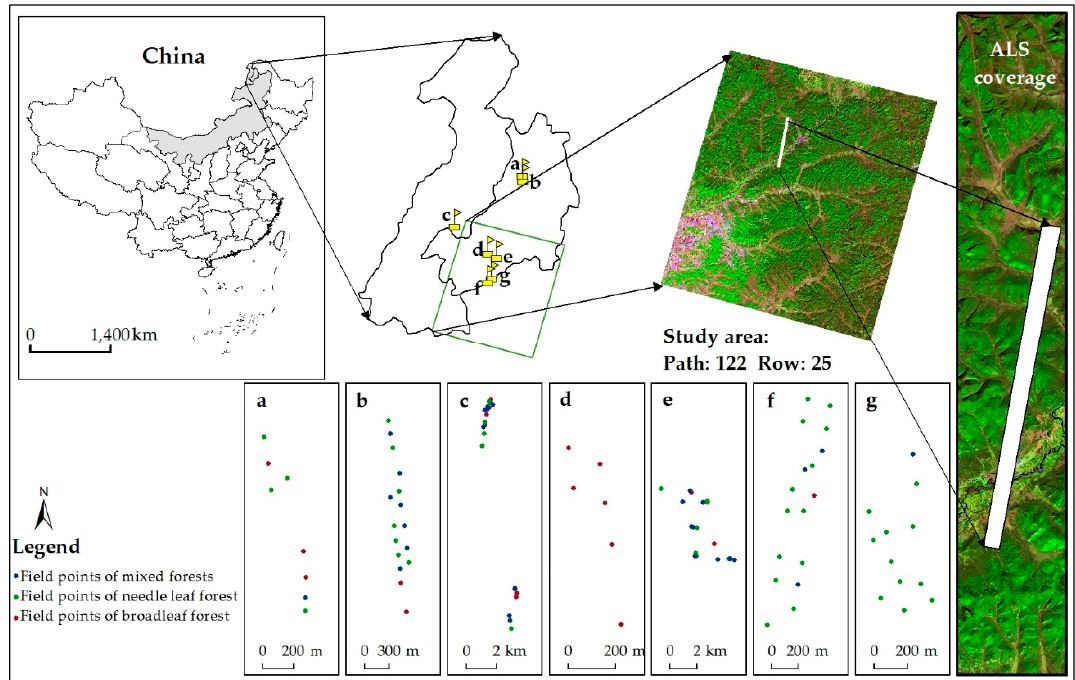
Figure 1. The geolocation of the study area was covered by a pseudo-color composite (R: band 5, G: band 4, B: band 3) Landsat ETM+ image (path: 122, row: 25) for 2012 with overlaid ALS coverage strip; Blue, Green and red points represented field points of mixed forests, needle leaf forest and broadleaf forest, respectively.